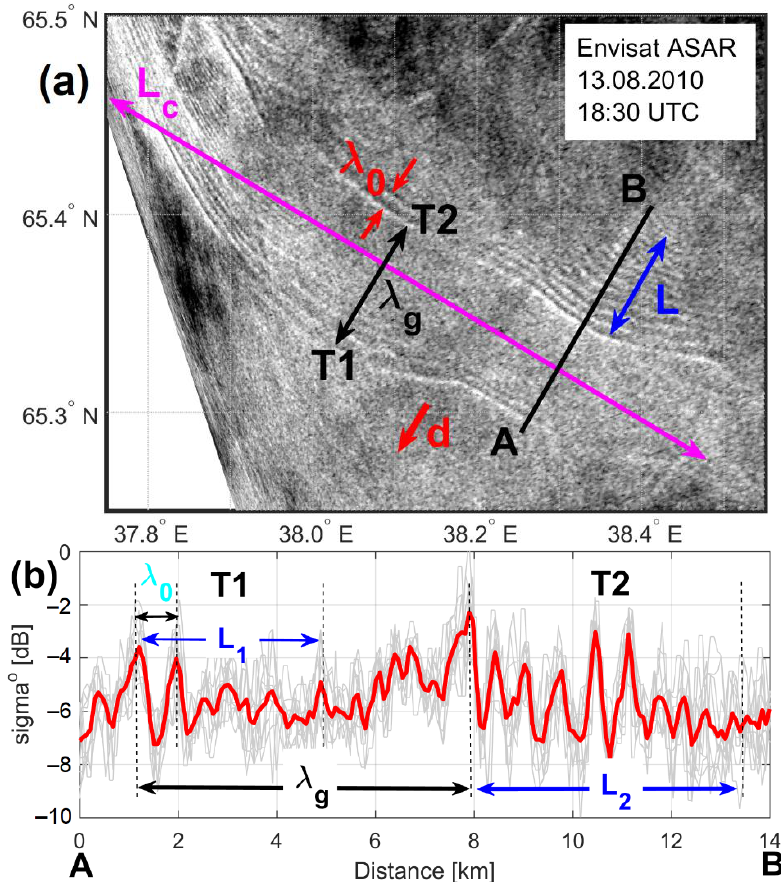
Figure 2. Detection of the ISW parameters from ( a ) an enlarged Envisat ASAR image acquired on 13 August 2010 at 18:30 UTC, and ( b ) SAR signal variations along the transect AB shown in ( a ).